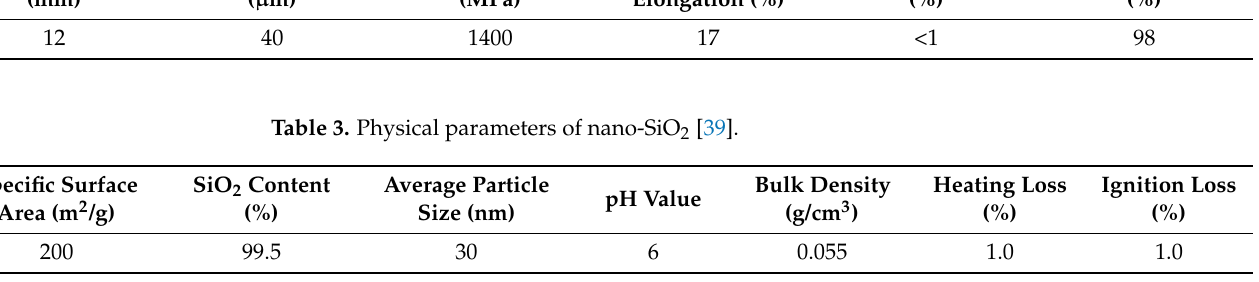
Table 4. Mixing proportions of the NFCC.